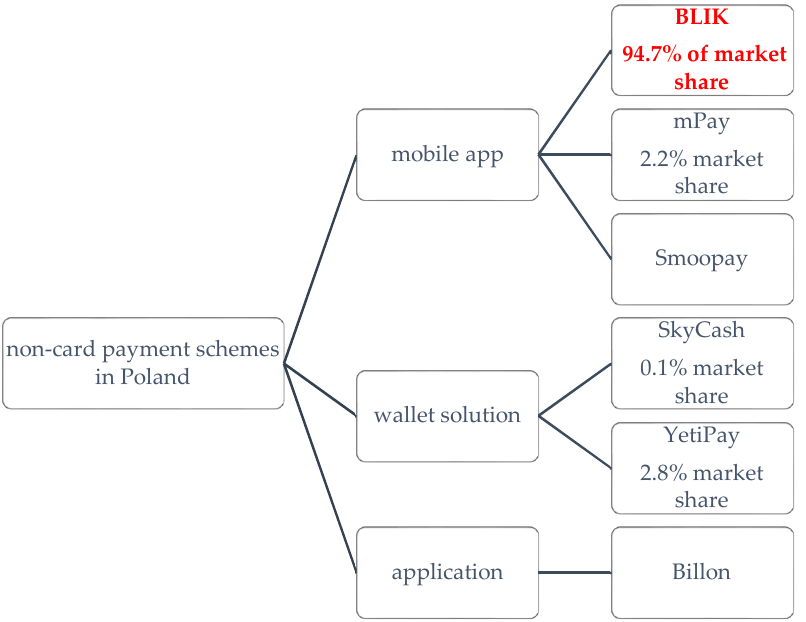
Figure 1. BLIK on the Polish retail payment market. Source: own elaboration based on information provided in the document NBP (2021a), list of payment systems under the oversight of the President of NBP; https://www.nbp.pl/en/system_platniczy/list-of-systems-and-schemes.pdf, accessed on 8 July 2021.